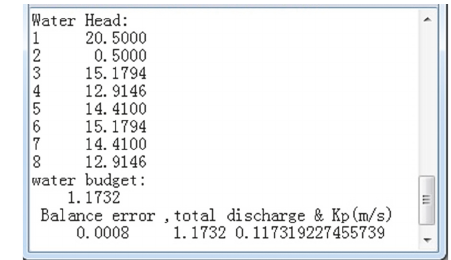
given head border and the upper and lower two boundaries are the impermeable